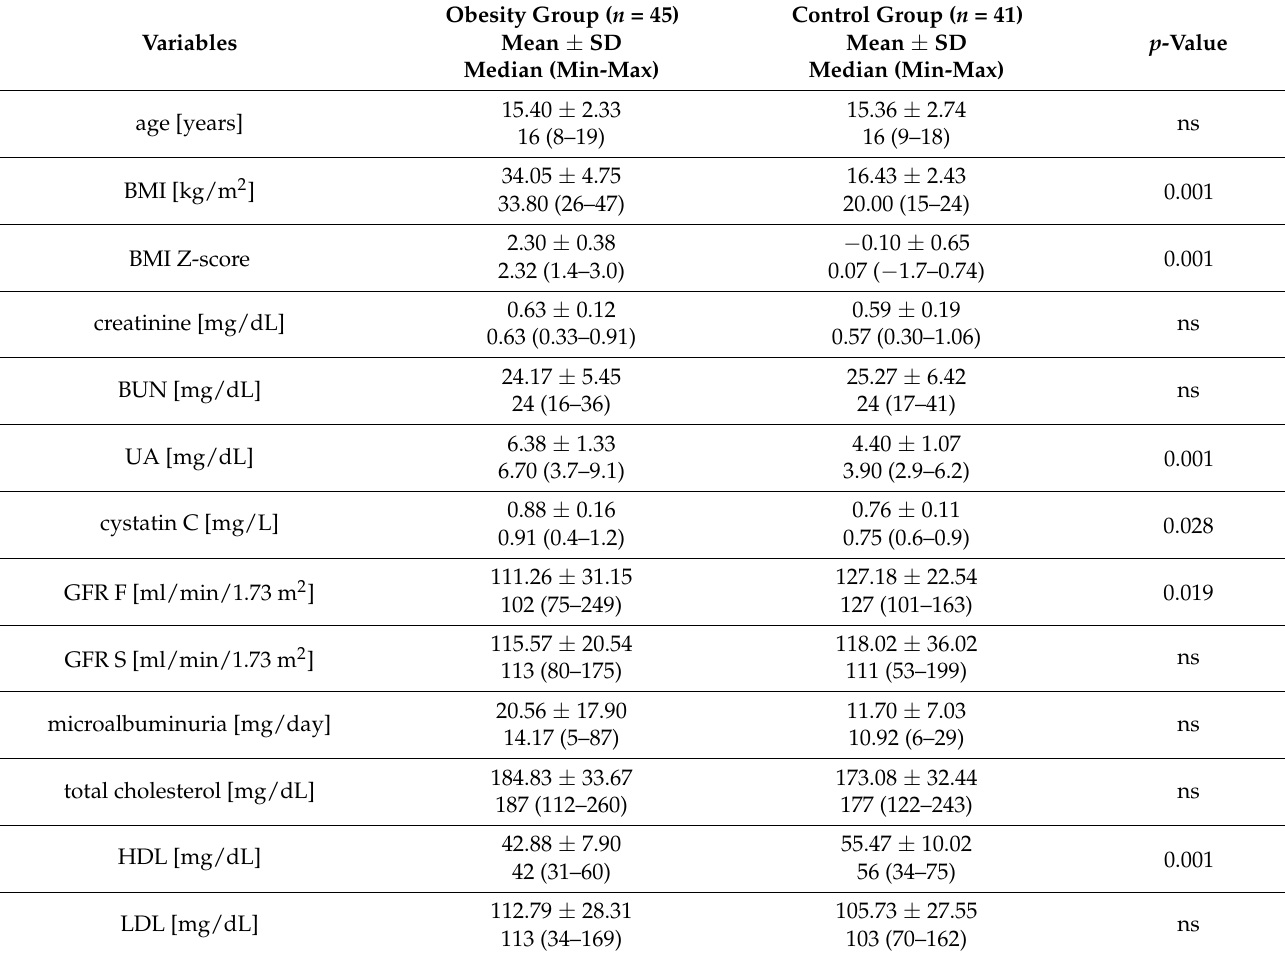
Table 2. Anthropometric, biochemical, and oral data for obesity group and control